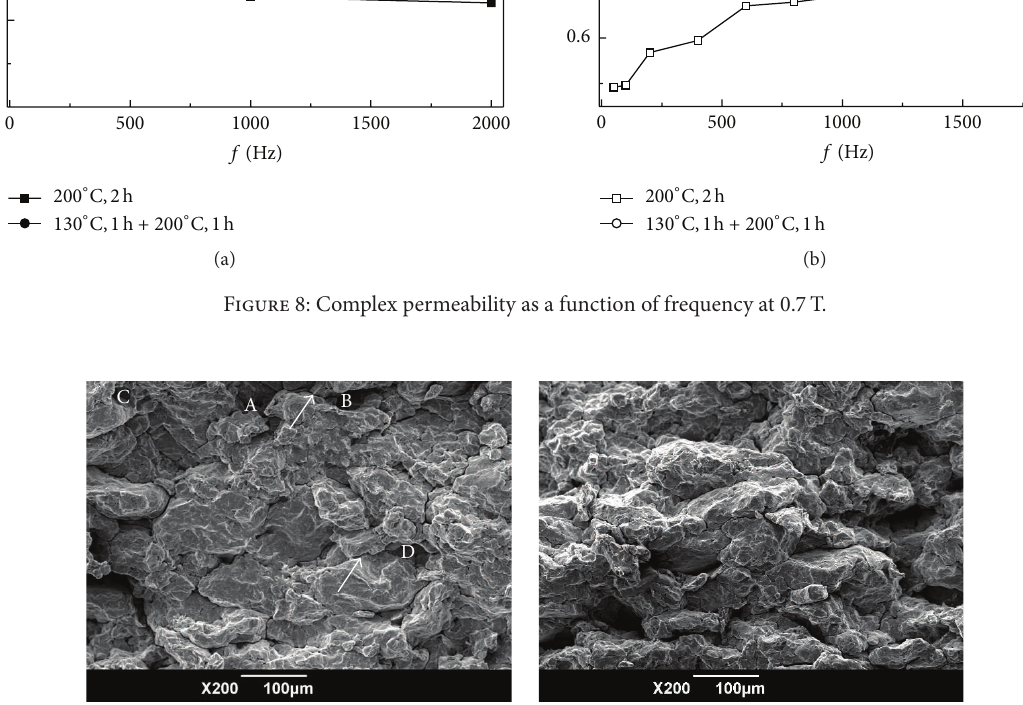
the stress is freed and corresponding bending deformation is